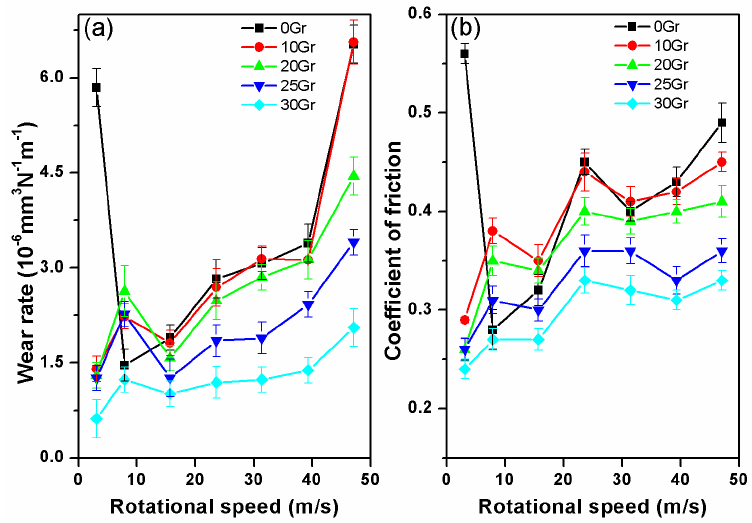
Figure 2. Variations of friction coefficient ( a ) and wear rate ( b ) of the PF-based friction composites with an increase in sliding speed at 0.51 MPa for 5 min.